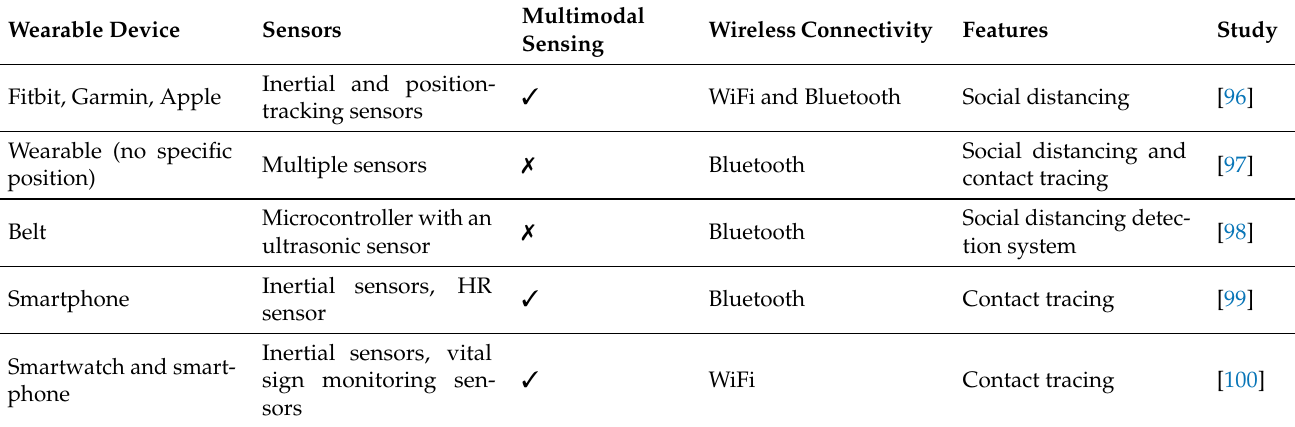
Table 4. Summary of recent research studies performed on contact tracing and social distancing in the context of COVID-19. Wearable